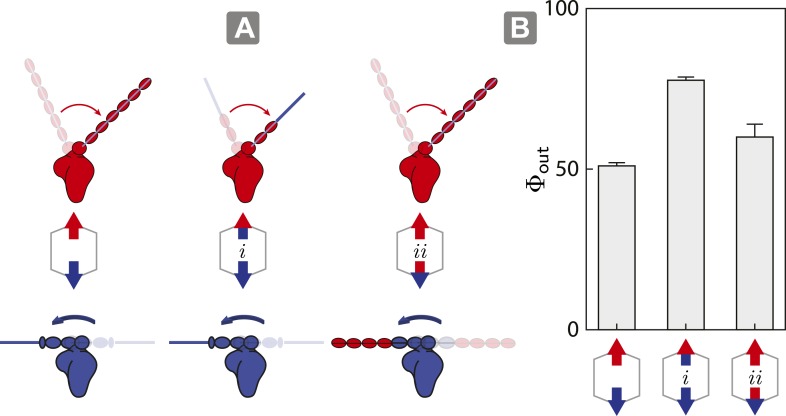
Switching lever arms restores myosin V dominance.(A) Scaffold and motor schematics used in the lever arm competition experiments. Lever arm rigidity was balanced by engineering the myosin V motor domain with the flexible lever arm of myosin VI (i; flexible vs flexible competition), or the myosin VI motor domain chimera with the rigid lever arm of myosin V (ii; rigid vs rigid competition). Arrowheads and arrowtails depict the myosin heads and lever arms, respectively (red—myosin V; blue—myosin VI). (B) Outward flux (Φout) of indicated motor ensembles. Error bars are S.E.M. and were generated by bootstrapping (N ≥ 126 trajectories; ≥ 3 keratocytes).